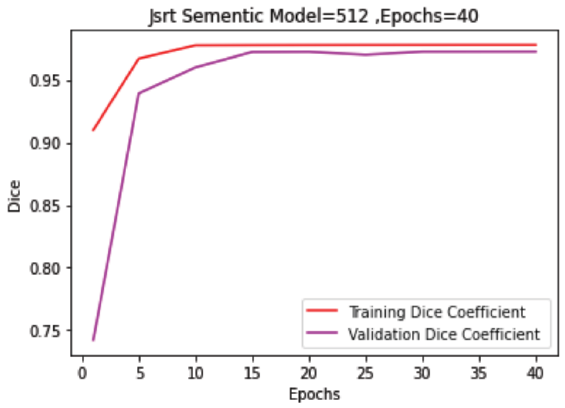
FIGURE 4 DICE SCORE COEFFICIENT RESULTS FOR OUR MODEL. (cid:2)